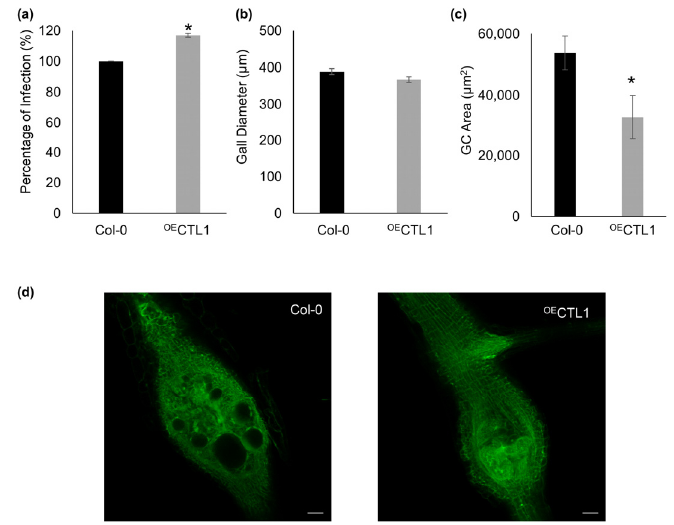
Figure 4. Altered expression of CTL1 yields a decrease in the GC’s size. ( a ) Infection tests showing the percentage of galls formed in the CTL1 over-expressing line ( OE CTL1) compared to Col-0 wild-type. Gall diameter ( b ) and GCs’ size ( c ) at 14 dpi in the control and transgenic line. ( d ) Confocal micrographs of representative galls and GCs at 14 dpi for the different lines. Bars indicate average values of the different parameters measures ± standard errors. Asterisks (*) indicate statistical significance ( p < 0.05 after students t -test; n = 5 independent galls, 10 sections each). Scale bars: 50 μ m.